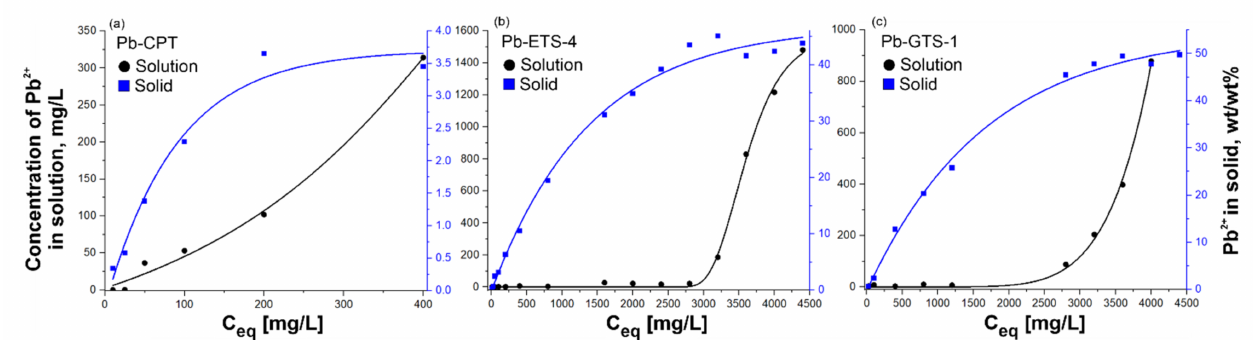
Figure 5. Representation of the adsorption isotherms for Pb(II) ion removal of ( a ) Pb-CPT, ( b ) Pb-ETS-4, and ( c ) Pb-GTS-1; experimental conditions: 1 g of adsorbent, initial pH 5.4, Pb(II) concentration 5–4500 mg/L, and adsorption period 2 h.